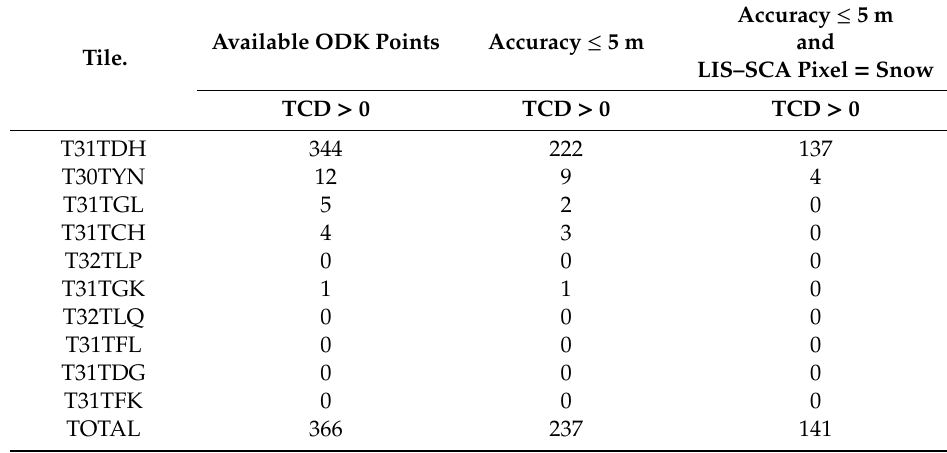
Table 7. Summary of the ODK Collect data obtained on March 15, 2020. In bold is the total number of collected ODK–FSC eventually used for the Sentinel-2 FSC